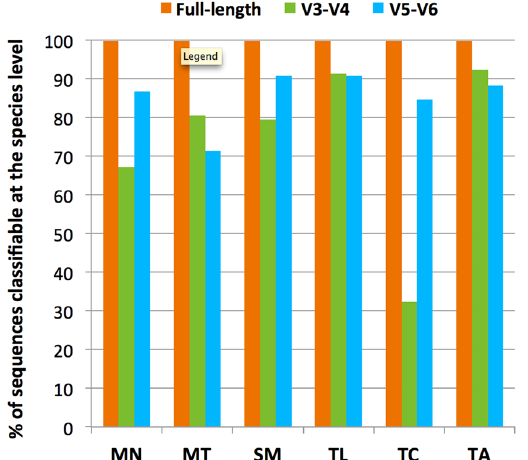
Figure 6. A histogram illustrating proportions of sequence reads from each sampling site that are classifiable at the species level using full-length (orange) or partial 16S rRNA gene fragments (V3-V4, green; V5-V6,